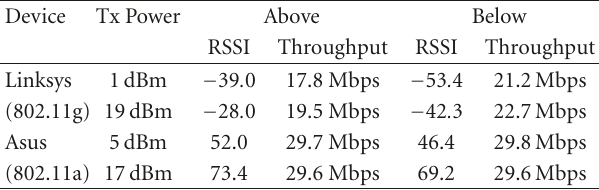
Table 1: Impact of the false floor on the link performance.